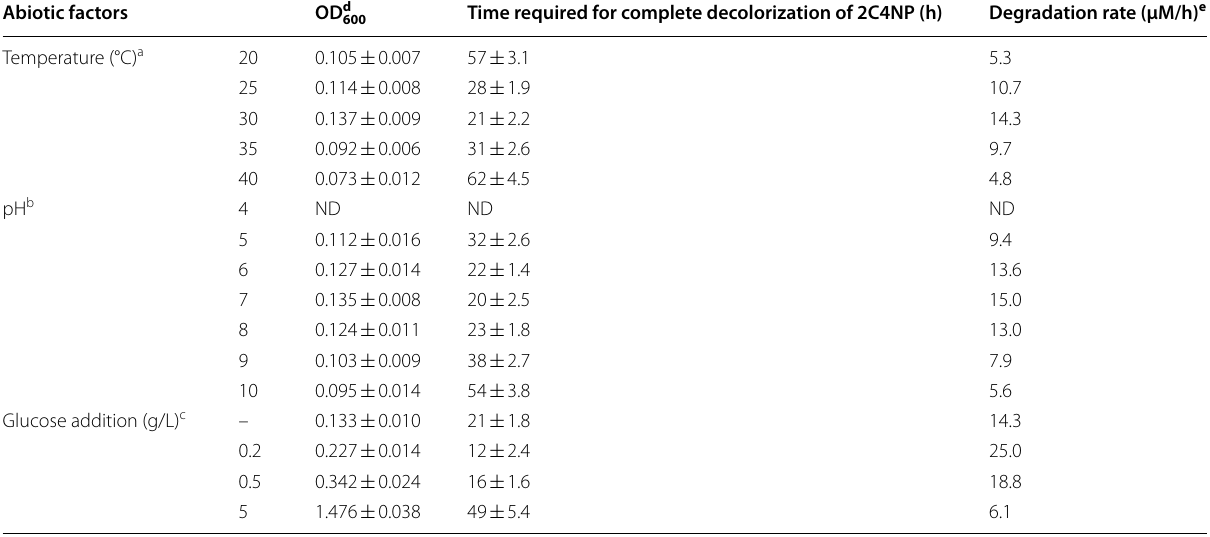
Table 1 Effect of temperature, pH, and glucose addition on 2C4NP degradation by strain CNP-8